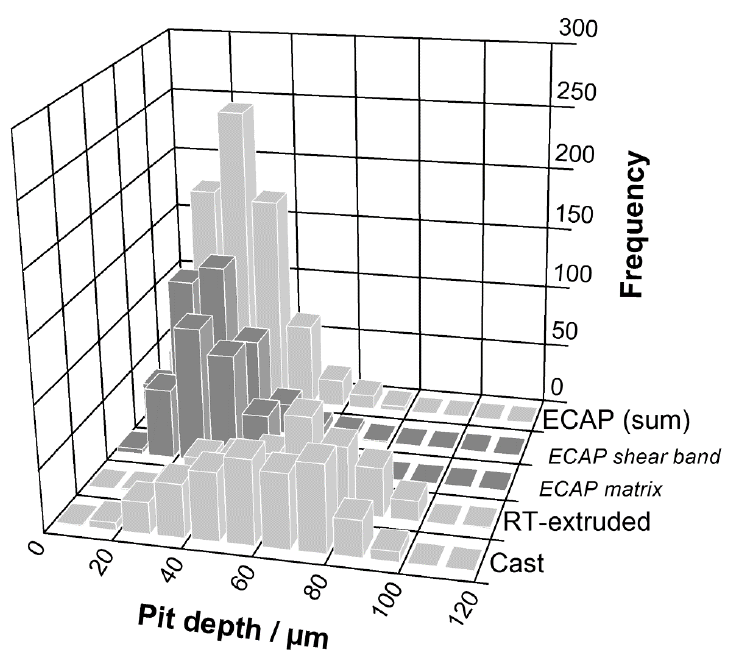
Figure 10. Frequency distribution of pit depths for different material conditions, additionally matrix and shear band are considered